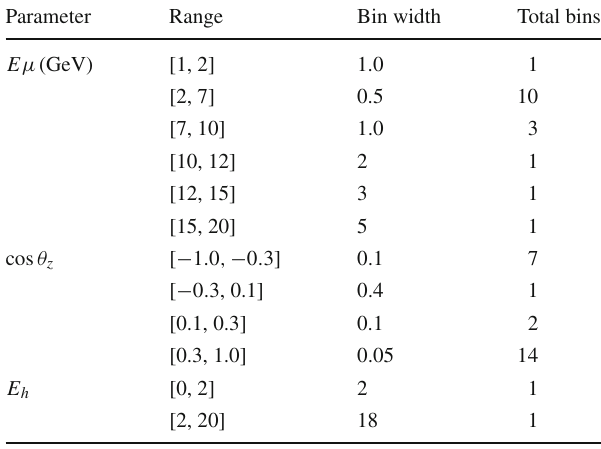
Table 5 The binning scheme adopted for the reconstructed parameters E μ ,cos θ z and E h formuons andhadrons where χ 2 isestimatedconsid- ering combined muon and hadron information and for the up-coming and down-going neutrino induced events Parameter Range Bin width Total